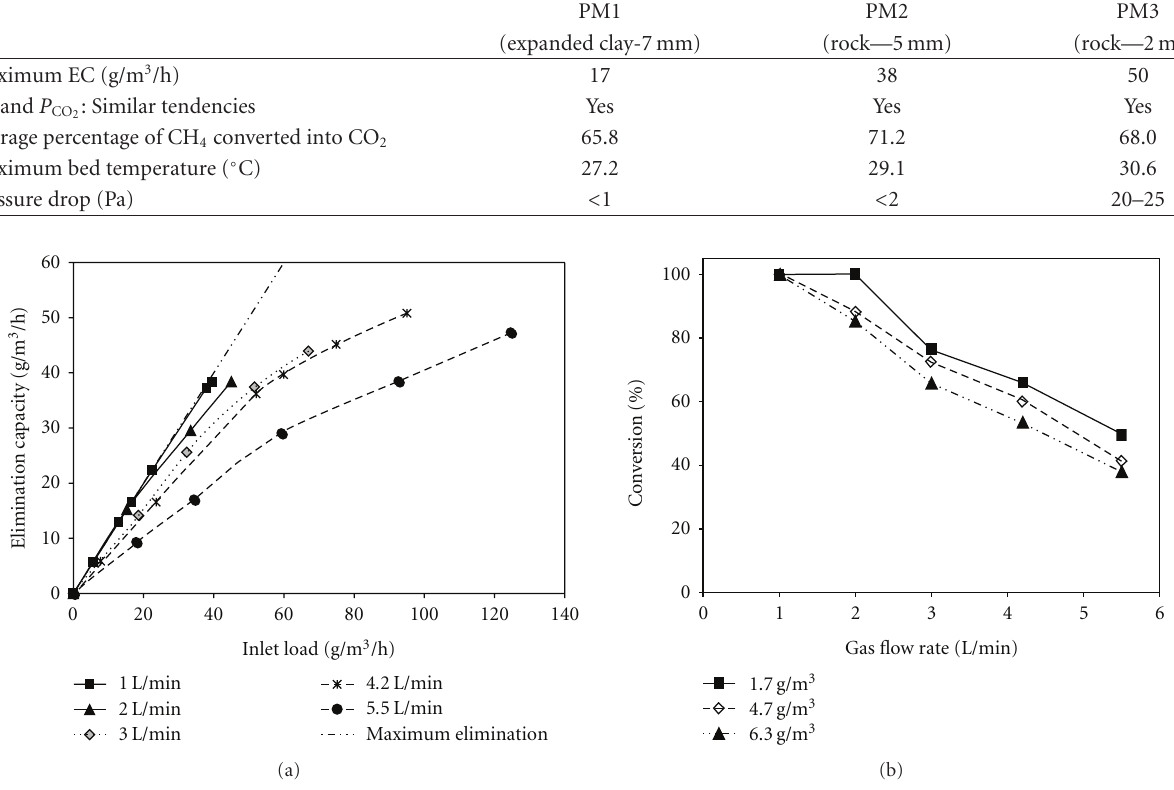
Figure 5: (a) EC of CH 4 within the biofilter packed with PM3 as a function of the IL for GFR comprised between 1 and 5.5 L/min. (b) CH 4 conversion as a function of the GFR for CH 4 concentrations of 1.7, 4.7, and 6.3 g/m 3